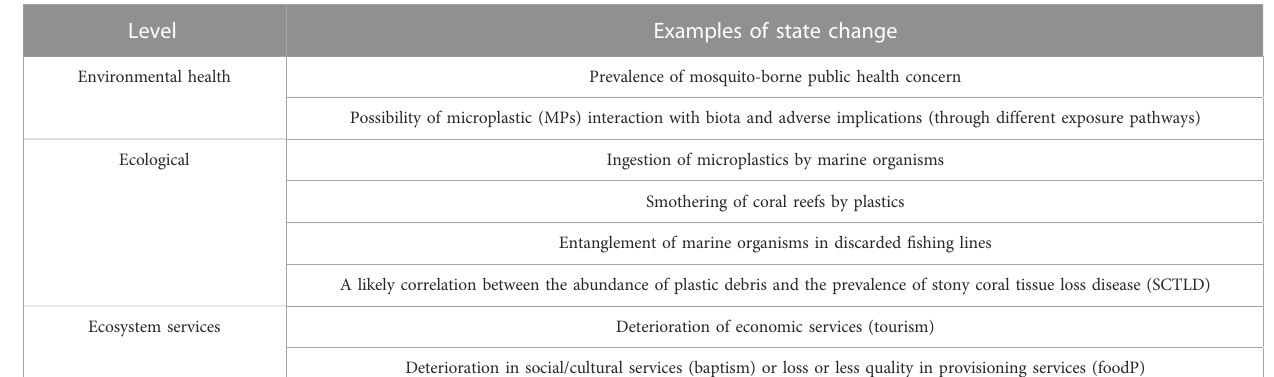
TABLE 3 Levels of state changes in the